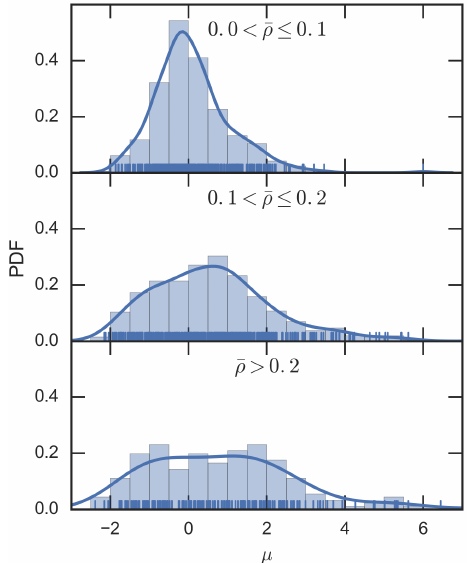
Figure 15. Normalized frequency (bars) and kernel density (line) of the gamma PSD shape factor µ in three ensemble mean density ranges, [ ρ ] = gcm − 3